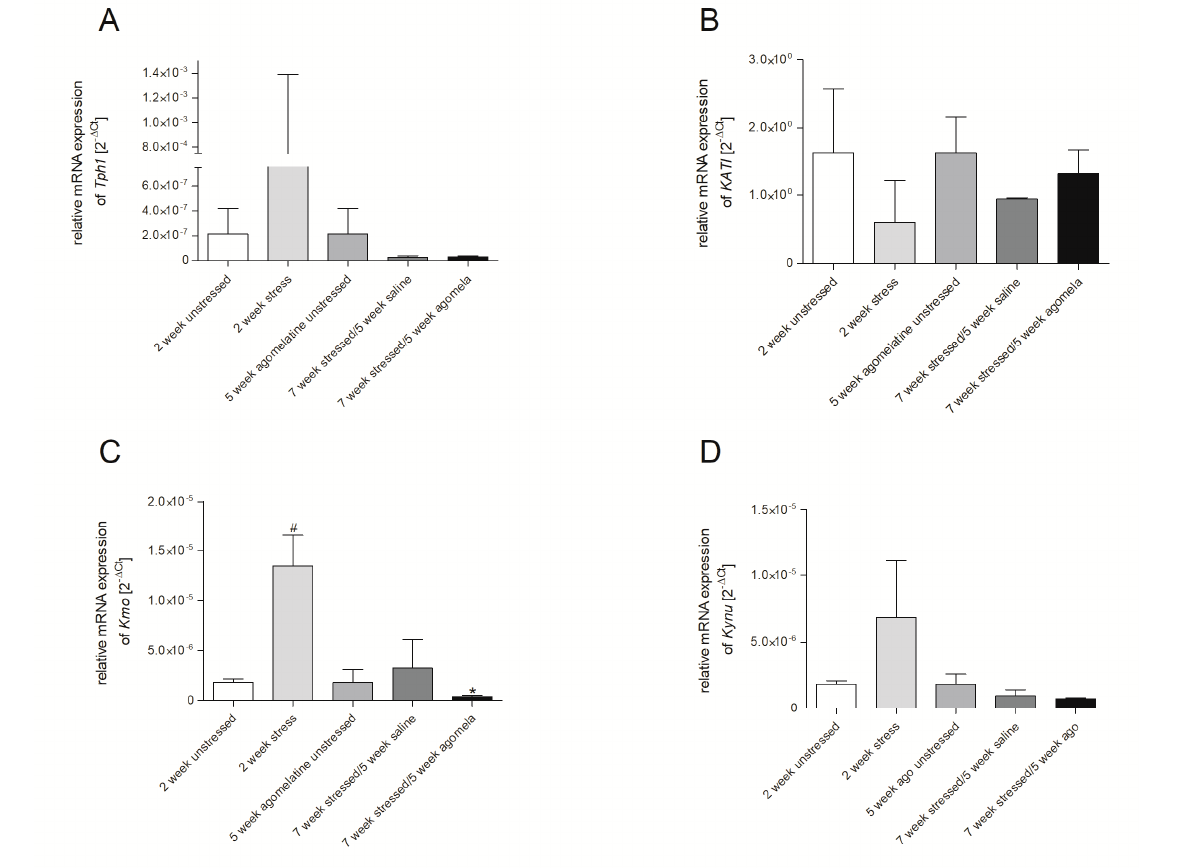
Figure 2. Tph1 ( A ), KatI ( B ), Kmo ( C ), and Kynu ( D ) messenger RNA (mRNA) expression in peripheral blood mononuclear cells (PBMCs0 of rats non-exposed and exposed to CMS for two weeks (2 weeks unstressed, 2 weeks stress), in animals non-exposed to CMS for seven weeks and administered agomelatine (10 mg / kg) for five weeks (5 weeks agomelatine unstressed), and in animals exposed to CMS for seven weeks and administered vehicle (1 mL / kg) or agomelatine (10 mg / kg) for five weeks (7 weeks stressed / 5 weeks saline and 7 weeks stressed / 5 weeks agomelatine). Relative gene expression levels were estimated using the 2 − ∆ Ct (Ctgene–Ct18S) method; n = 6; # p < 0.05 for di ff erences between 2 weeks stressed and 2 weeks unstressed groups, * p < 0.05 for di ff erences between 2 weeks stressed and 7 weeks stressed / 5 weeks agomelatine groups.